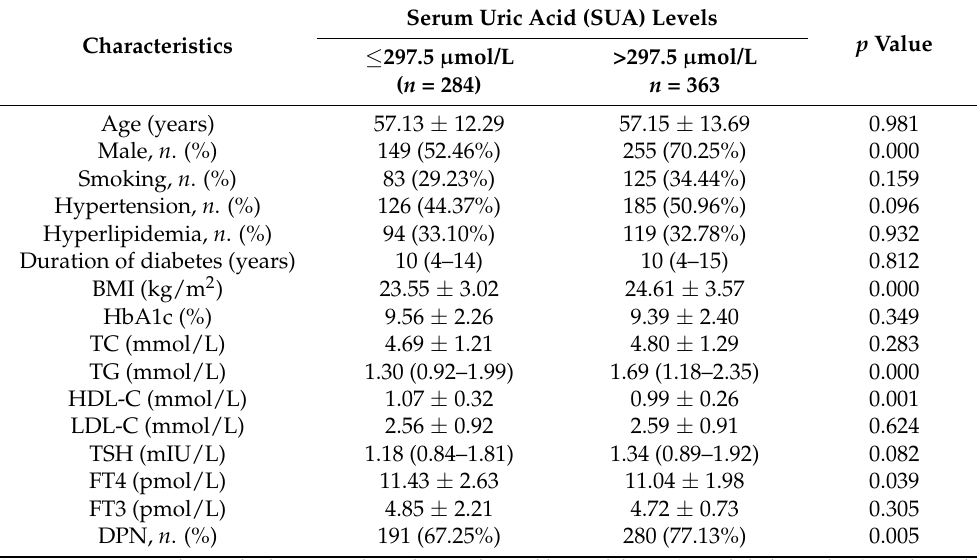
Table 2. Comparison of the baseline characteristics between subgroups based on the optimized cut-off of SUA level.